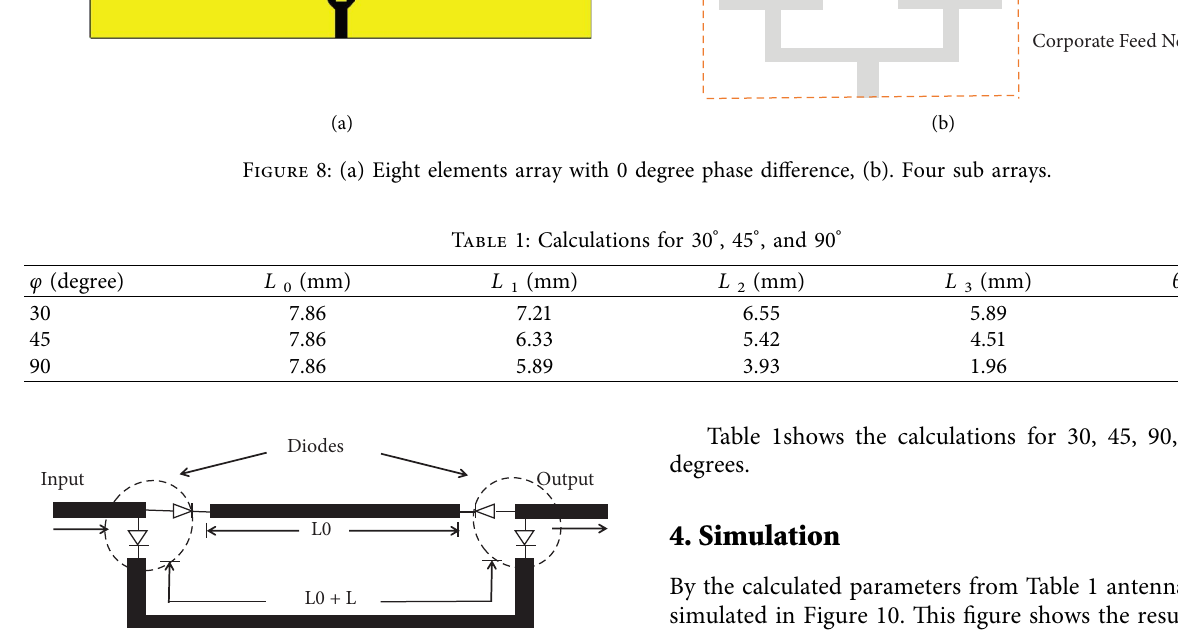
Figure 9: Basic schematic of phase shifter operation using diodes [19].